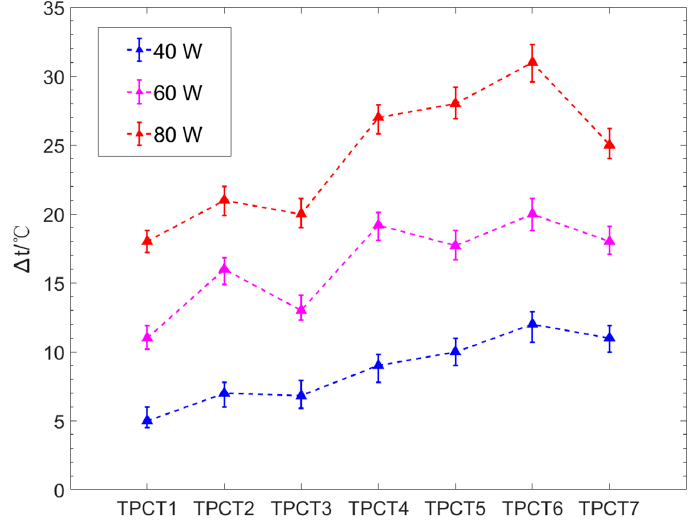
Figure 8. Relationships between wall superheat degree ∆ t /°C on evaporator section and di ff erent TPCTs with various